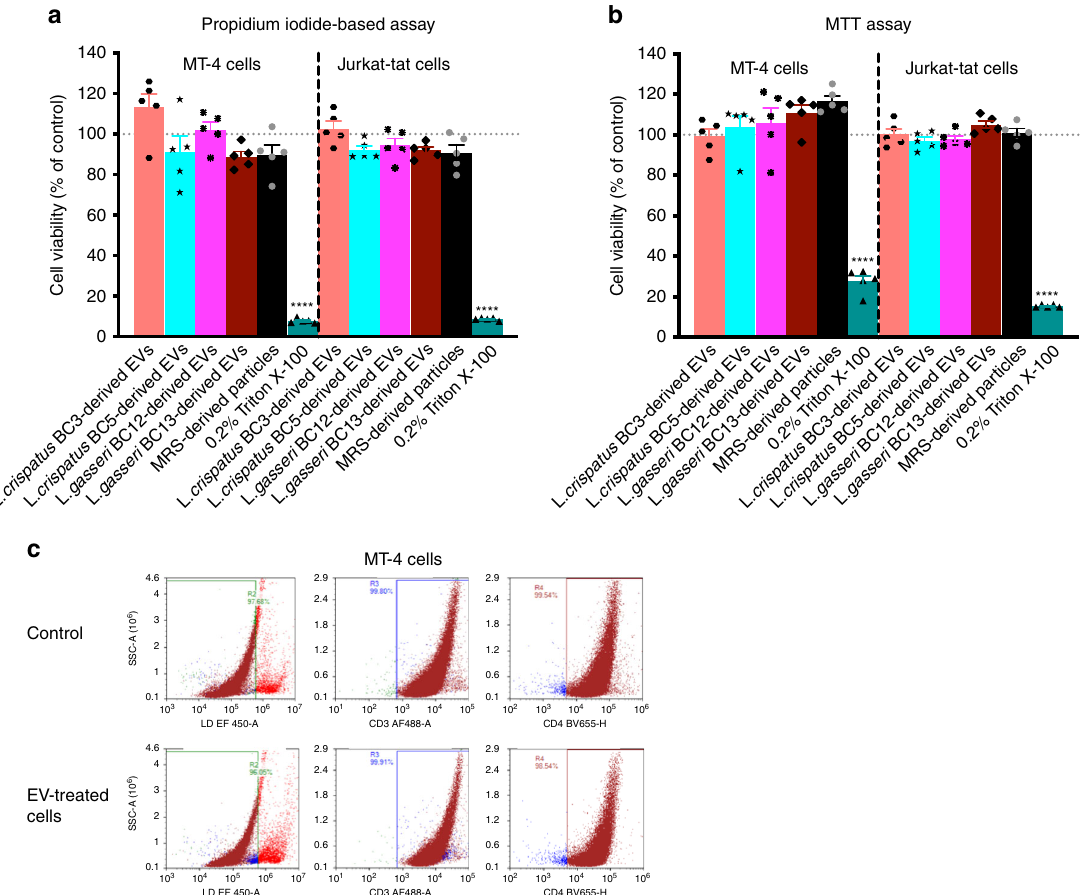
Fig. 3 Viability of cells treated with Lactobacillus -derived EVs. MT-4 and Jurkat-tat cells were treated or not treated for 3 days with EVs (5 × 10 8 EVs per mL) isolated from four Lactobacillus strains ( L. crispatus BC3, L. crispatus BC5, L. gasseri BC12, L. gasseri BC13), and with particles derived from MRS medium. Triton X-100 (0.2%) was used as a cytotoxic agent. a The numbers of viable cells were counted according to a propidium-iodide-based assay. Results are expressed as percentages of viable cells in EV-free or EV-treated cells. Presented are means± SEM from fi ve independent measurements. b Cell viability according to MTT assay. Results are expressed as percentages of viable cells in EV-free or EV-treated cells. Presented are means ± SEM from fi ve independent measurements. c Cell depletion in MT-4 cell cultures treated with L. gasseri BC12-derived EVs (5 × 10 8 EVs per mL), as measured with fl ow cytometry. Panels from left to right represent staining for live/dead cells, CD3, and CD4 populations in EV-untreated cells (upper row) and in cells treated with Lactobacillus- derived EVs (lower row). Asterisks indicate statistical signi fi cance by one-way ANOVA multiple comparison with Dunnett ’ s correction (**** p < 0.0001). Source data are provided as a Source Data fi